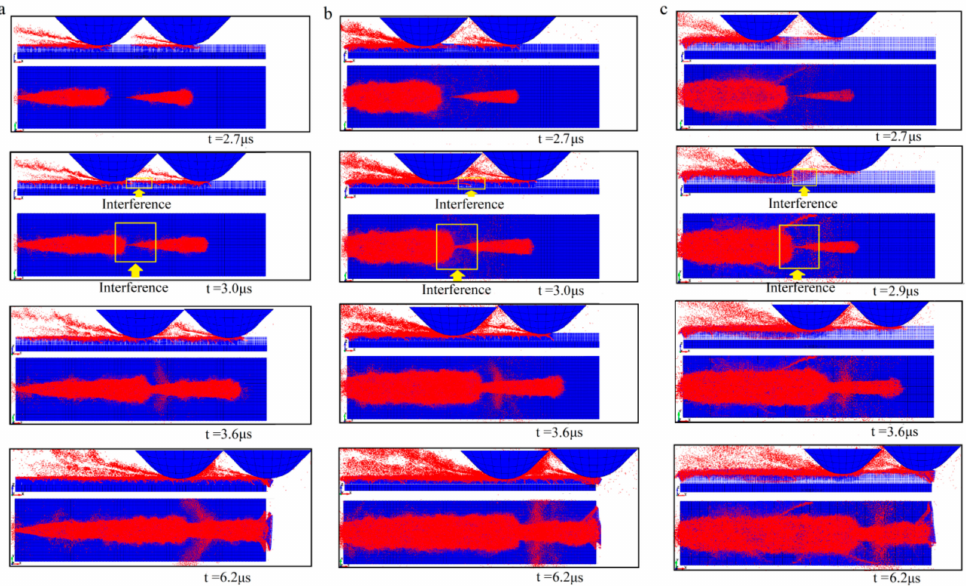
Figure 6. Damage interference nephograms of two grit scratching of single crystal SiC with a Z-axis spacing along the DOC direction at di ff erent times, ( a ) ∆ d z is 0.5 µ m, ( b ) ∆ d z is 2.5 µ m, and ( c ) ∆ d z is 5 µ